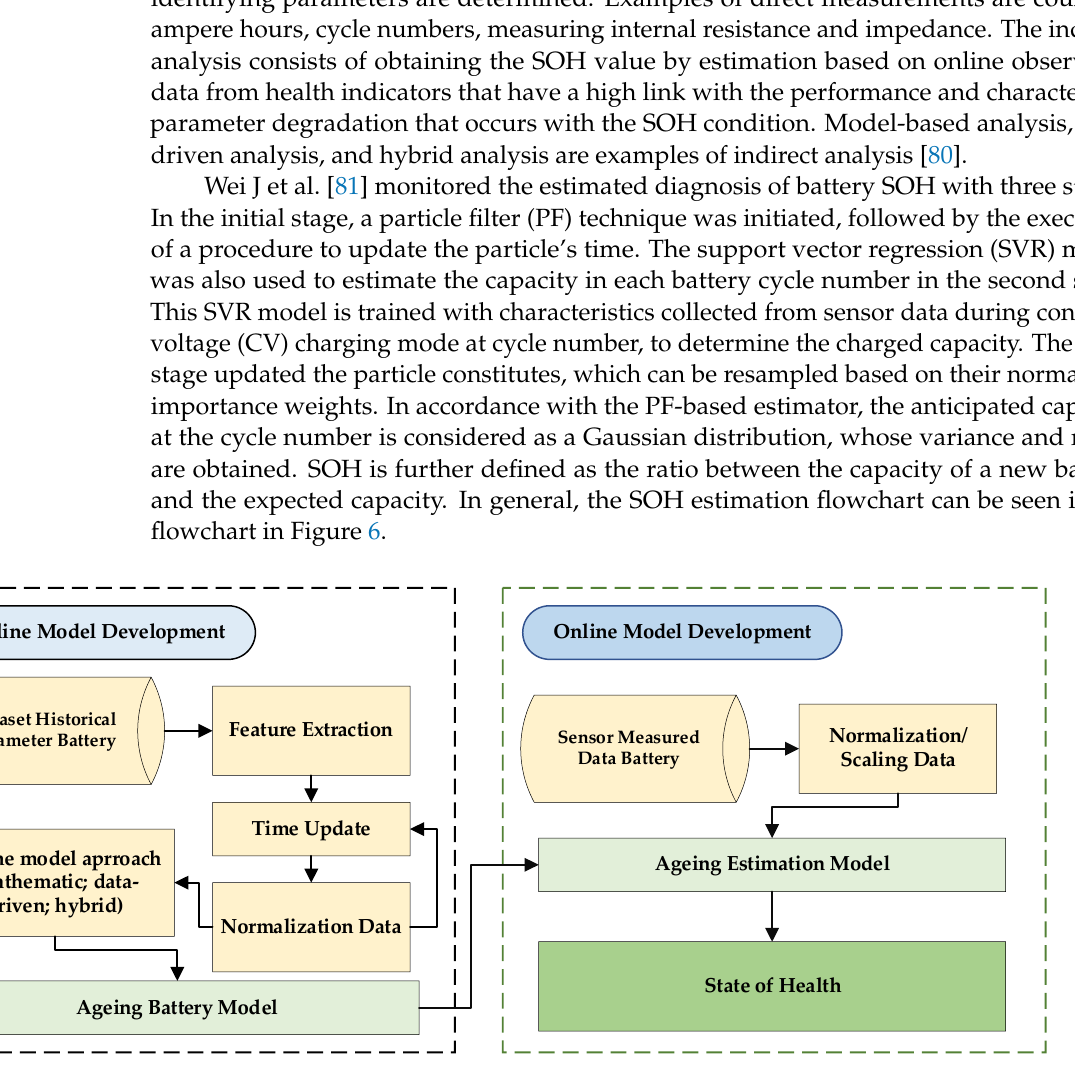
Figure 6. Block diagram of SOH estimation in general.